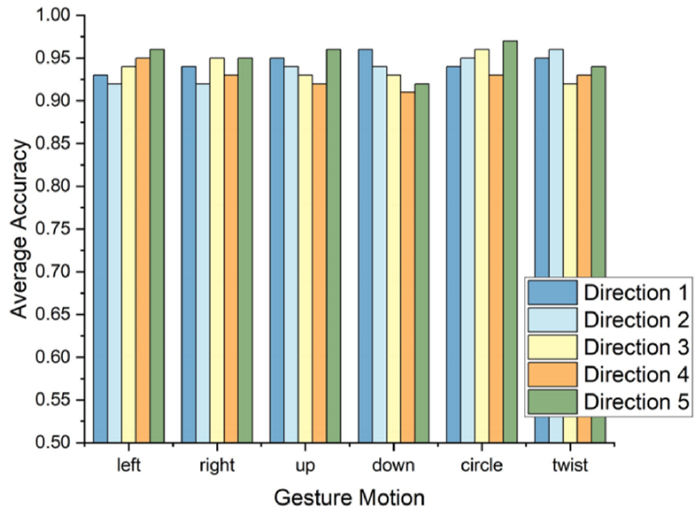
Figure 15. Influence of different directions on recognition effect.